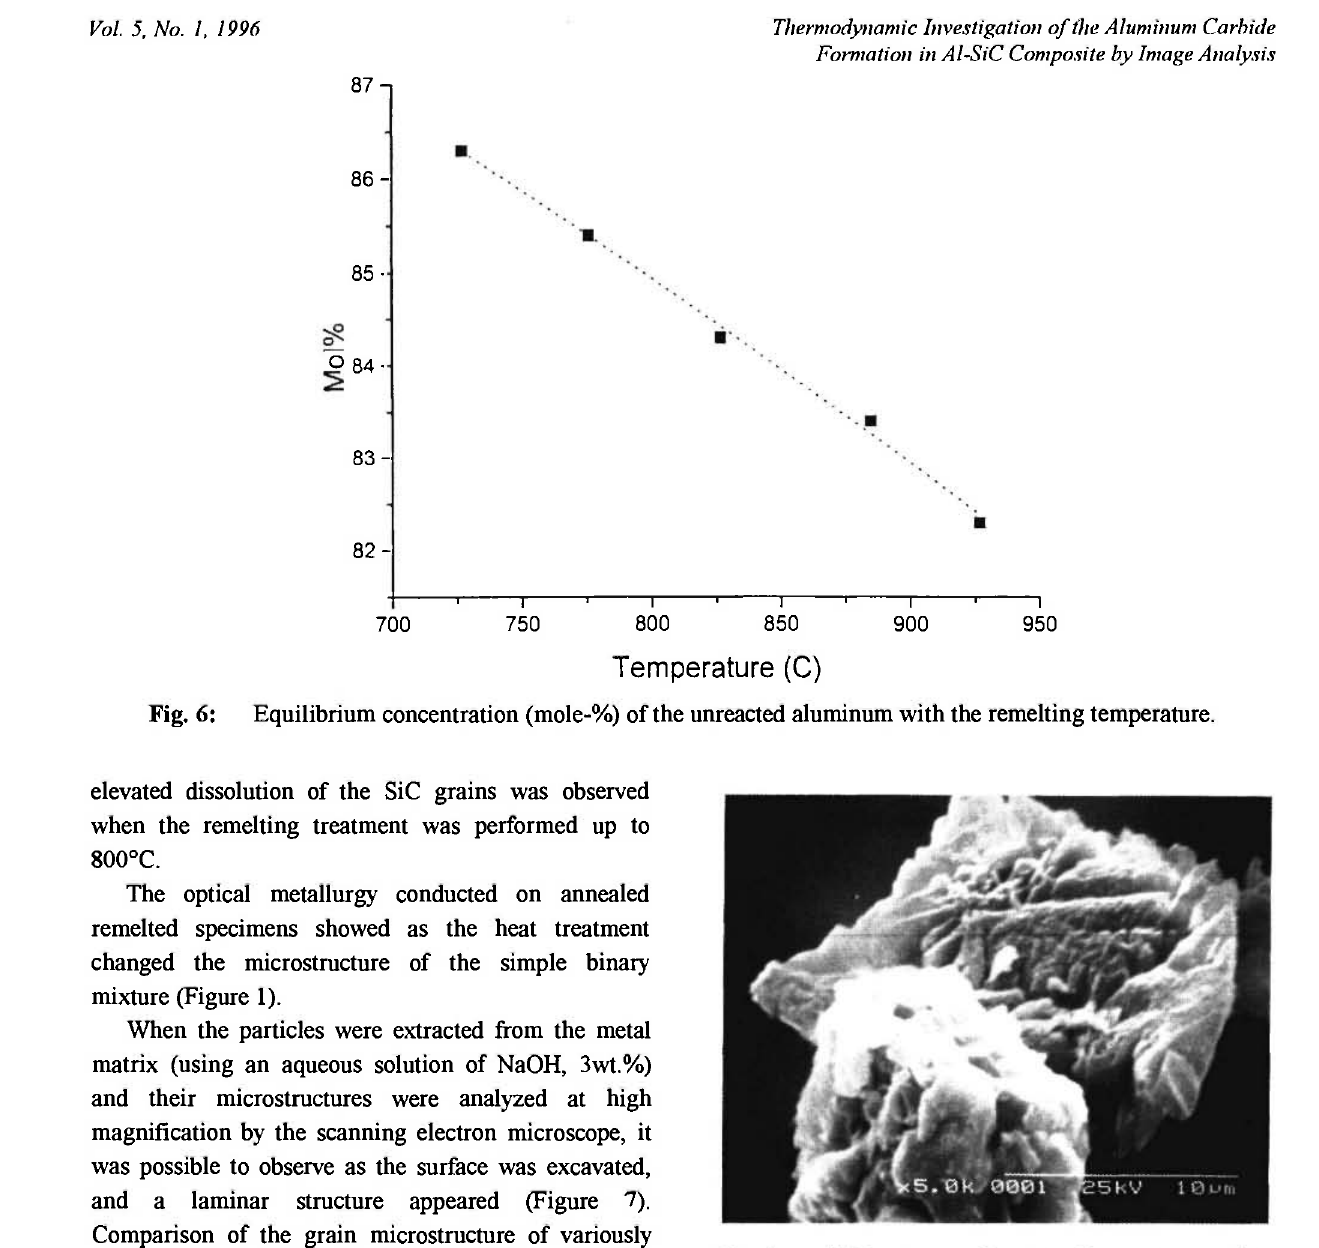
(Figure 7). Fig. 7: SEM-micrograph of the SiC particle microstructure after extraction from the metal matrix with a solution of NaOH (3 wt.%). The particle surface appears partially excavated (3h at